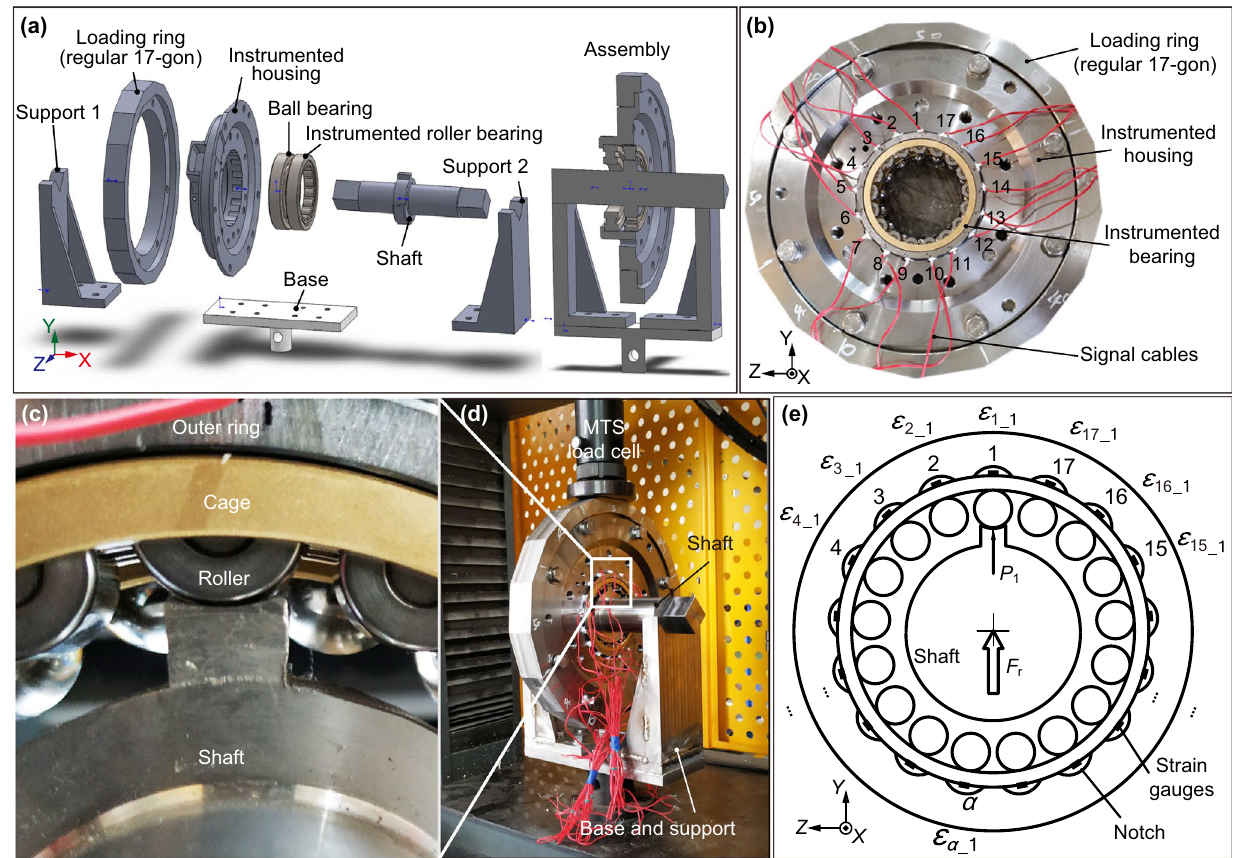
Fig. 4 a – d Experimental setup for determining the calibration matrix and e the schematic diagram of the test of the calibration matrix compo- nents